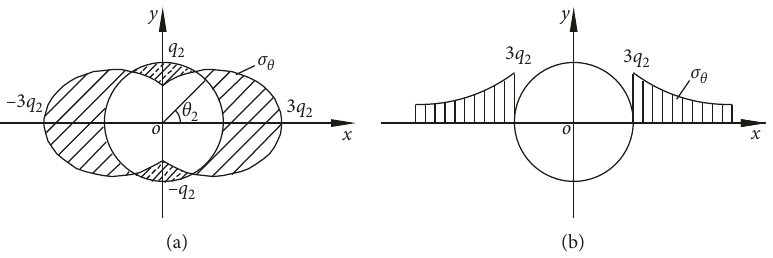
Figure 2: The diagram of stress concentration on the hole wall of the empty hole due to the transverse wave. (a) Hole wall stress. (b) Hole edge stress.